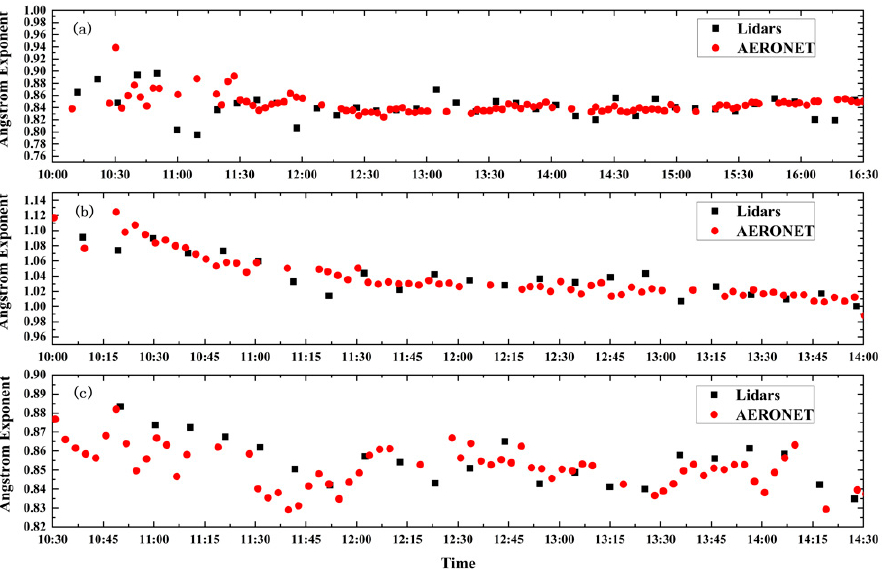
Figure 3. Ångström exponents comparison of three-day experiment, where AE 532-1550 (black dots) with 10 min temporal resolution are retrieved from the datasets of joint measurements and AE 532-1550 (red dots) with 5 min temporal resolution are retrieved from datasets of the AERONET site. ( a ) 20